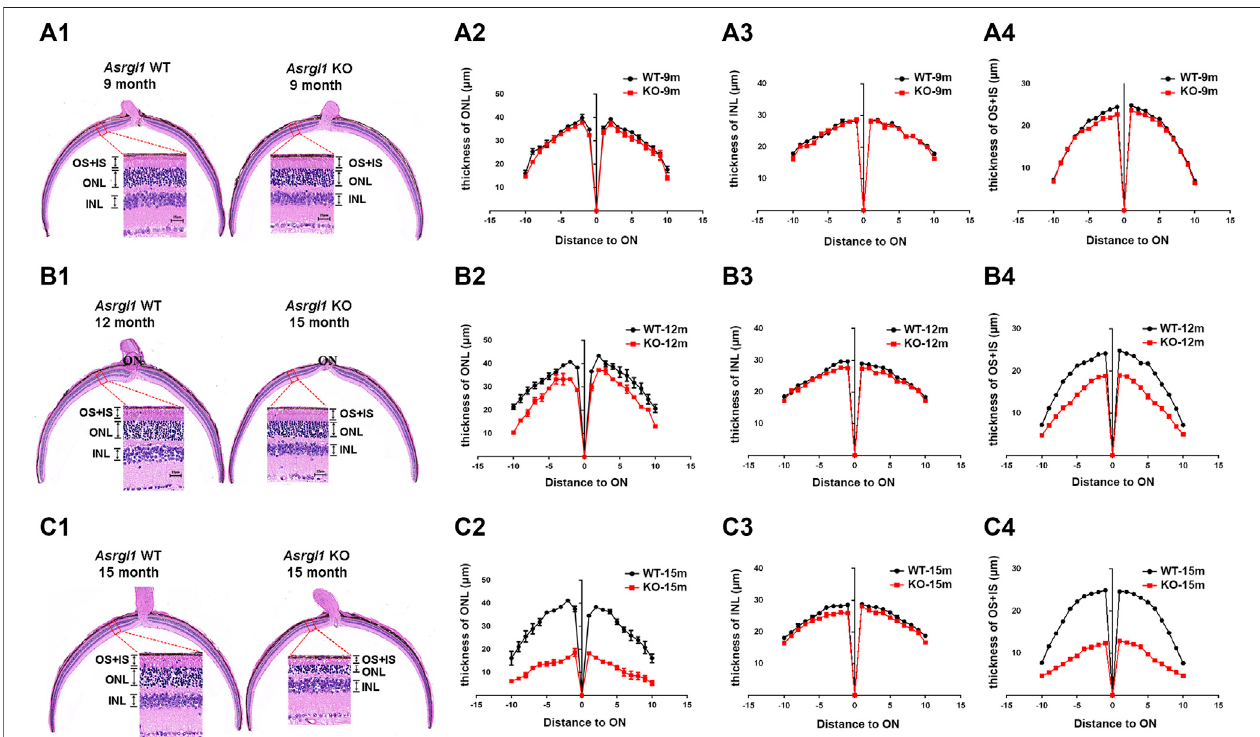
FIGURE 3 | Degeneration of the outer retina in Asrgl1 KO mice. (A1,B1,C1) Hematoxylin and eosin (H&E) staining of paraf fi n sections of the Asrgl1 KO and corresponding control retinas at the ages of 9, 12, and 15 months. Scale bar: 25 μ m. (A2,B2,C2) Quanti fi cation analysis of the outer nuclei layer (ONL) thickness of the KO ( n (cid:1) 6)and WT( n (cid:1) 6)retinasfrom miceat 9,12,and15 monthsold. (A3,B3,C3) Quanti fi cation analysisoftheinner nucleilayer(INL)thicknessoftheKO( n (cid:1) 6)and WT ( n (cid:1) 6)retinasfrommice at9,12,and 15 months old. (A4,B4,C4) Quanti fi cation analysisoftheouter segment(OS)plus inner segment(IS)thicknessoftheKO ( n (cid:1) 6)and WT( n (cid:1) 6)retinasfrommiceat 9,12,and15 monthsold. The Asrgl1 KOmouseretinasshowedadrasticallygradual degenerationofthephotoreceptorcells at 15 months old.